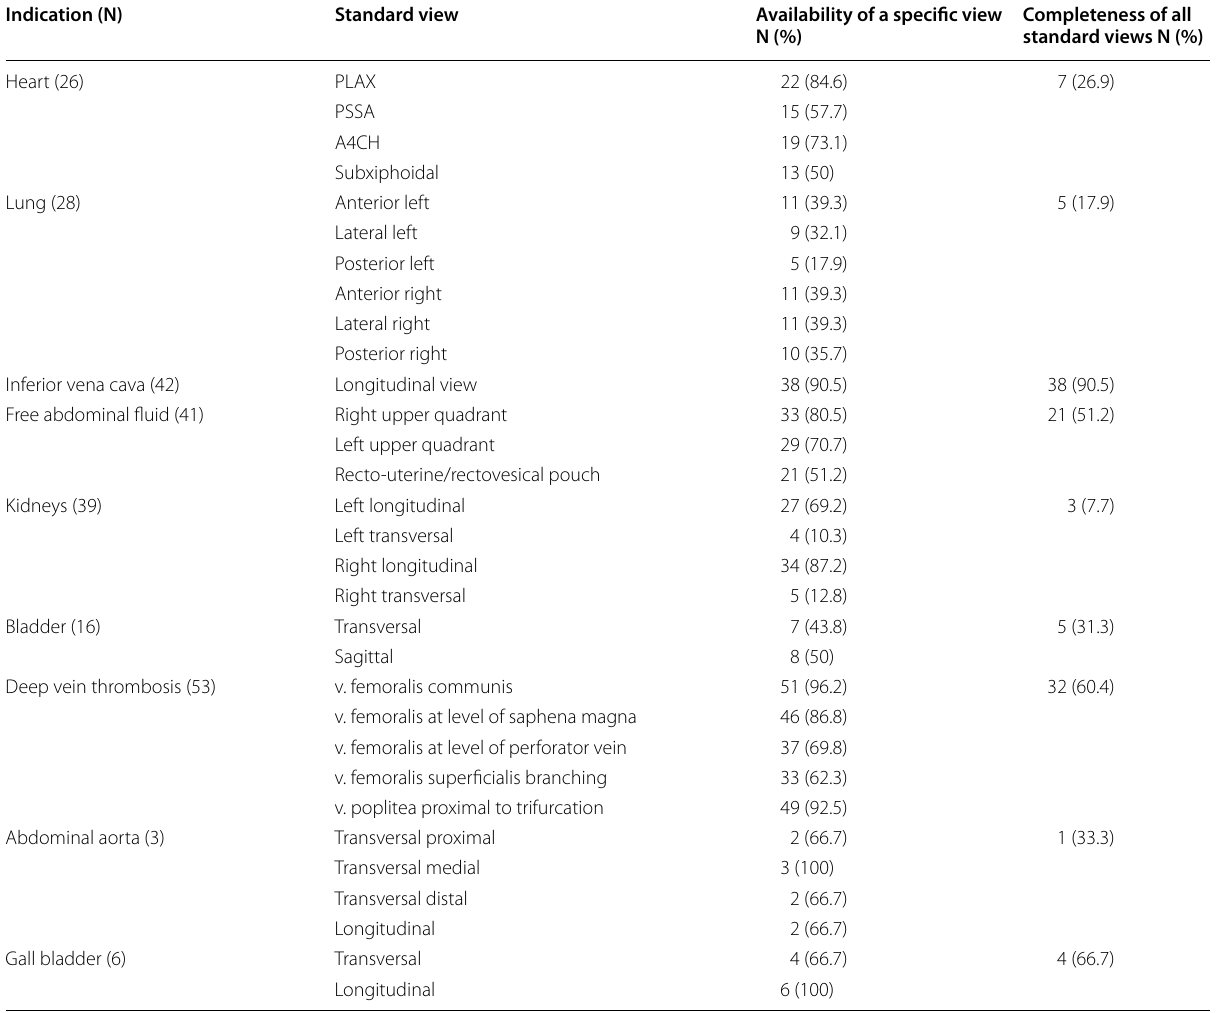
Table 2 Availability of specific views and completeness of standard views per